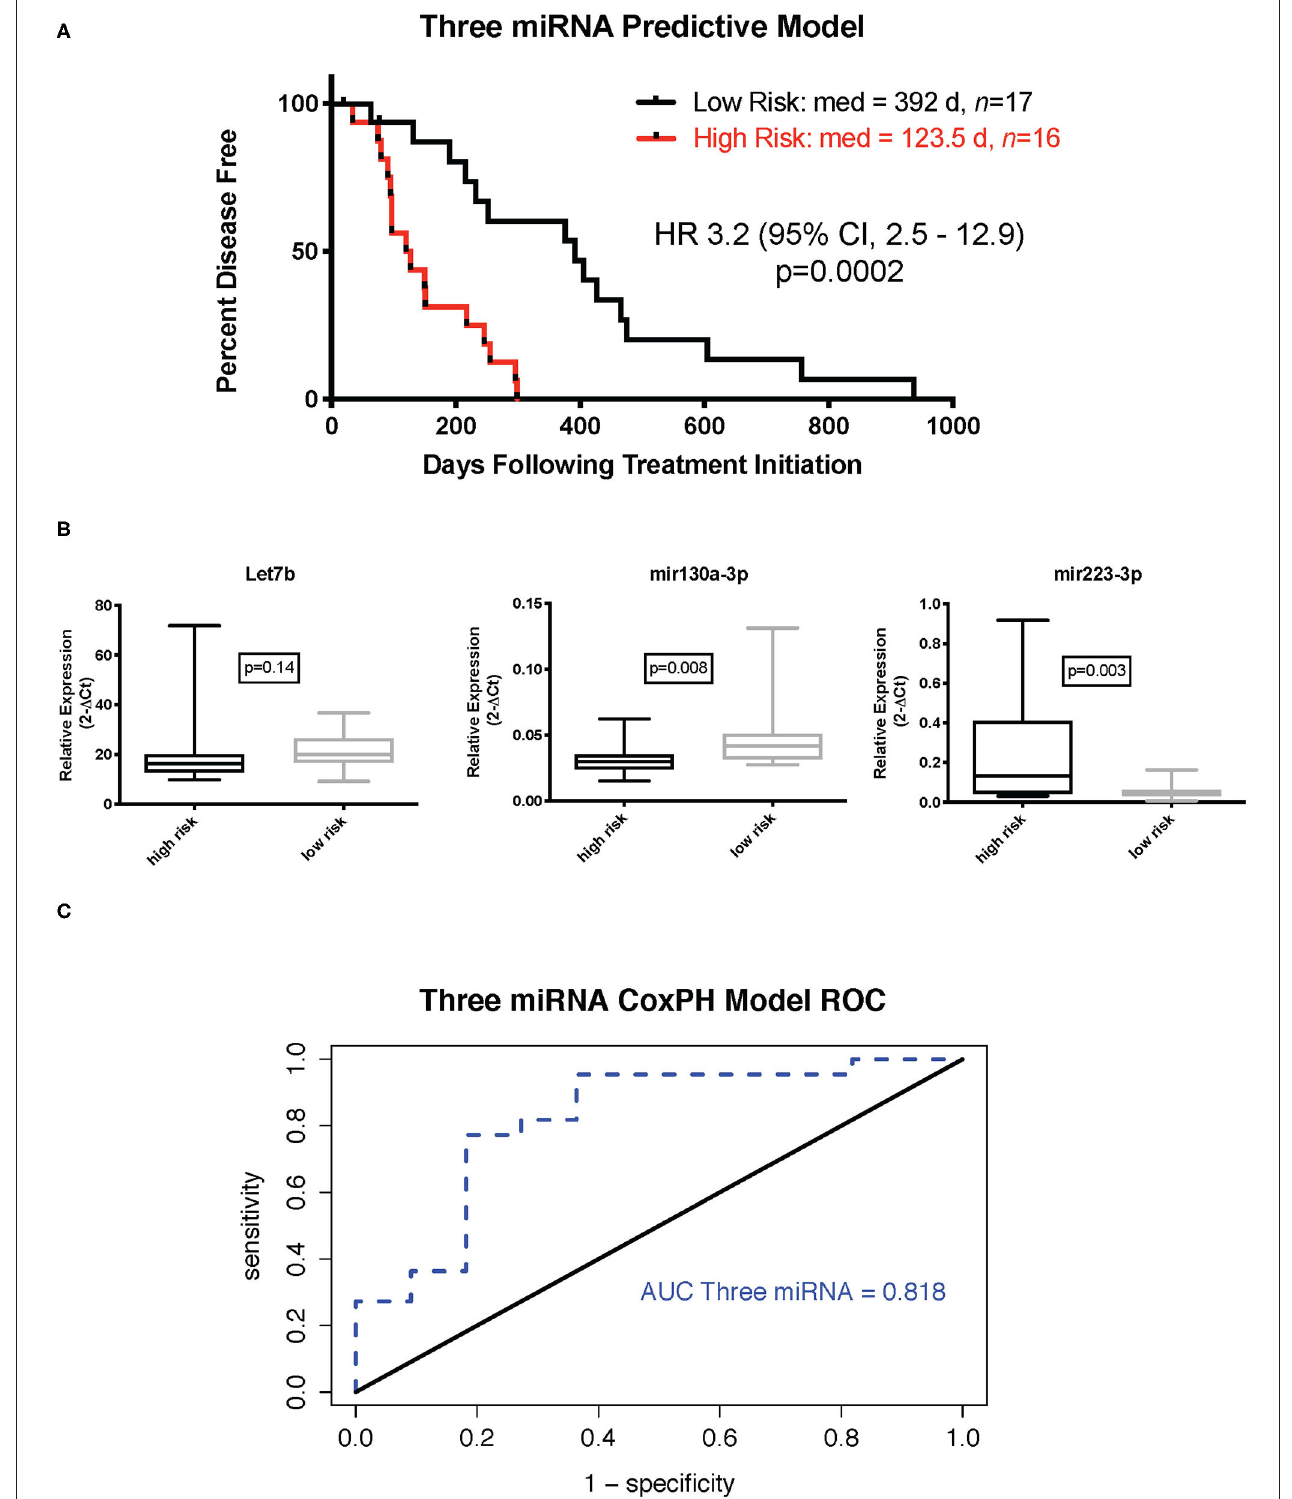
FIGURE 1 | Three-miRNA tumor-based predictive model. (A) Kaplan–Meier survival curve with log rank test (cutoff is median risk score: 0.8897). (B) Relative expression (2 − 1 Ct ) of individual miRNAs in low- and high-risk groups (Mann–Whitney test). (C) Receiver operator characteristic curve for three-miRNA Cox proportional hazard-based risk score dividing outcome groups based on mean disease-free